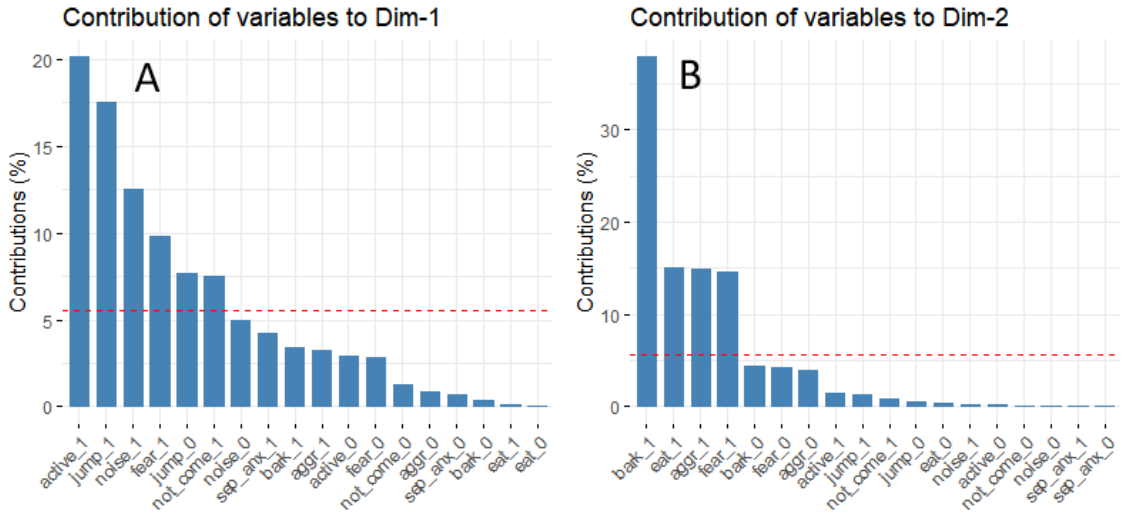
Figure 5. Contribution of each behavior problem to the top two dimensions of MCA. ( A ) Dim1 is characterized by hyperactivity, jumping, noise sensitivity, fear, and not coming when called and ( B ) Dim2 is characterized by excessive barking, eating-related problems, aggression, and fear. The red dashed line on the graph above indicates the expected average value if the items’ contributions would be uniform to the dimensions.